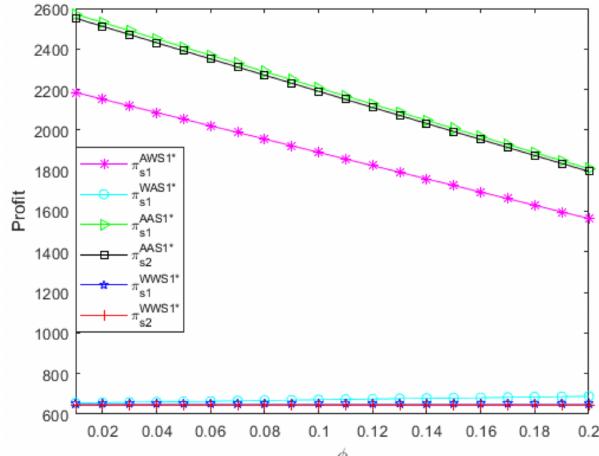
Figure 1. Changes of optimal pieces with φ in AAS1 and WWS1 models.